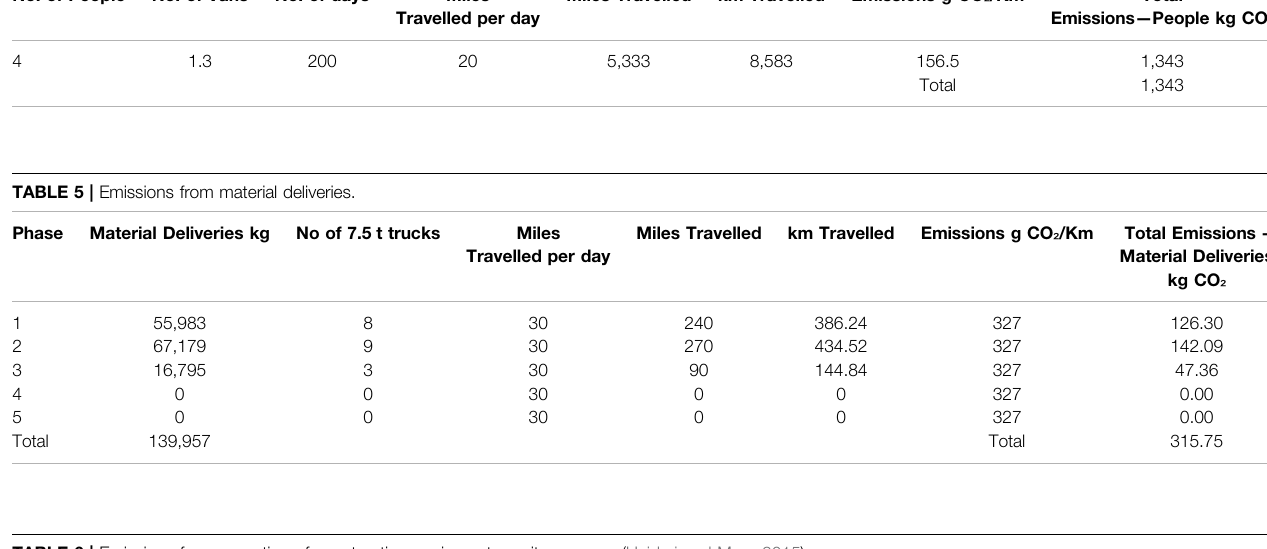
TABLE 6 | Emissions from operation of construction equipment on site — source (Heidari and Marr, 2015).